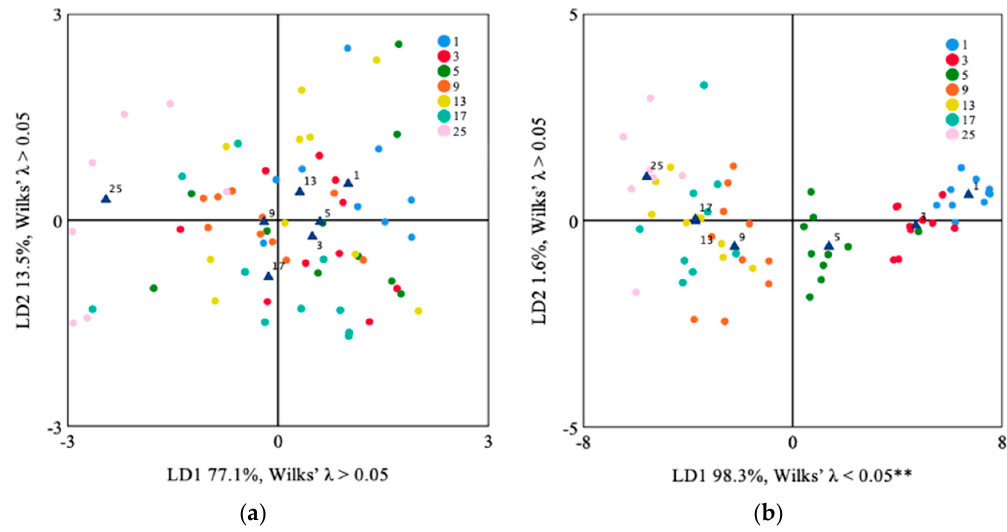
Figure 3. Canonical discriminant analyses performed on the Fourier coefficients of lapilli ( a ) and sagittae ( b ) from Sinogastromyzon wui of each age class. **, p < 0.01.